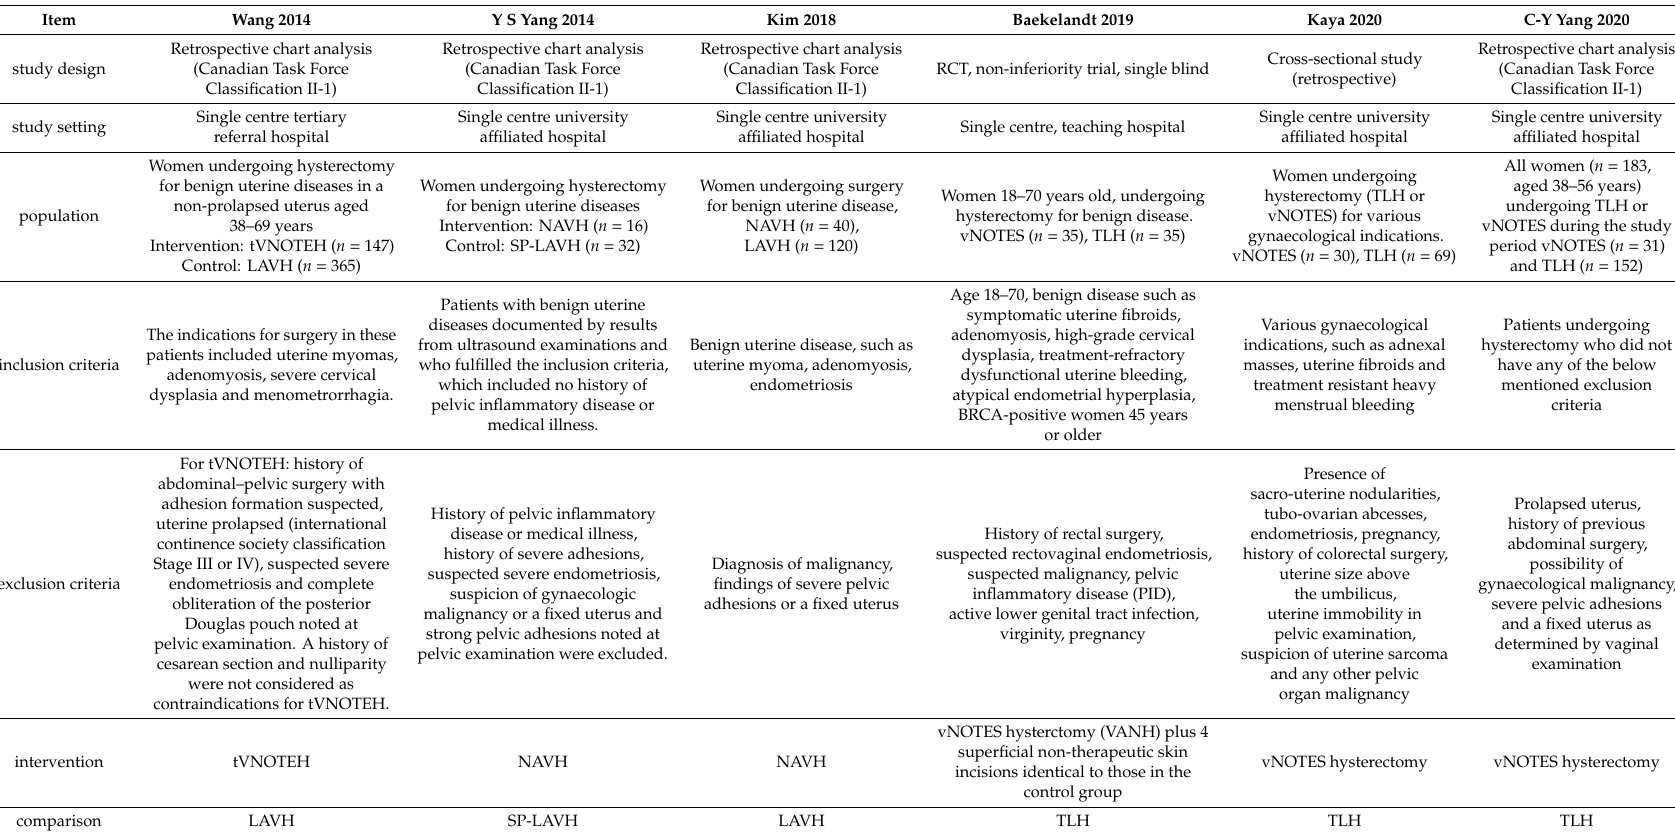
Table 1. Characteristics of the included